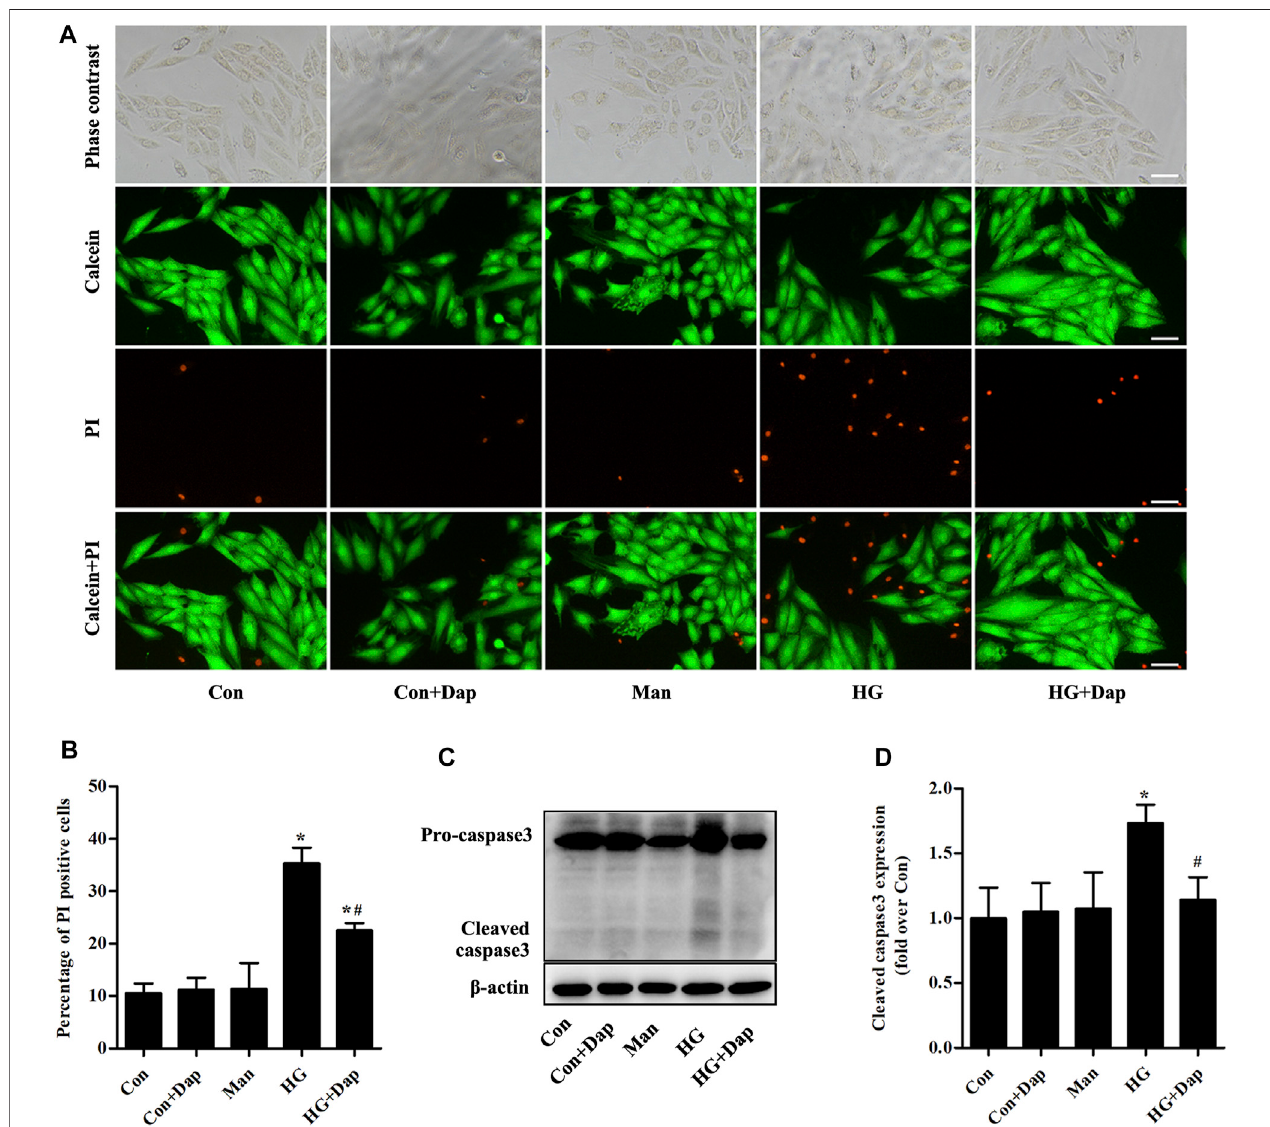
FIGURE 4 | Effects of DAP on high glucose-induced death of H9C2 cells. H9C2 cells were treated with 5.5 mM glucose (Con), 5.5 mM glucose plus 10 µM Dap (Con + Dap), 33.0 mM mannitol (Man), 33.0 mM glucose (high glucose, HG) or 33.0 mM glucose plus 10 µM Dap (HG + Dap) for 36 h. Calcein acetoxymethyl ester (Calcein-AM)/propidiumiodide(PI)stainingwasusedtodetectlive/deadH9C2cells (A) PanelshowsrepresentativephotomicrographsofCalcein-AM/PIstaining.Green fl uorescencebyCalcein-AMindicateslivingcells.Red fl uorescencebyPIrepresentsdeadcells.Scalebar (cid:1) 100 µm (B) Histogram representsquantitativeanalysis ofPIpositivecells (C,D) Panel and histogramrepresenttheexpression ofcleaved caspase 3inH9C2 cells. n (cid:1) 3 – 4.Dataare expressed asthemean ± SD. * p < 0.05 vs. Con; # p < 0.05 vs. HG.